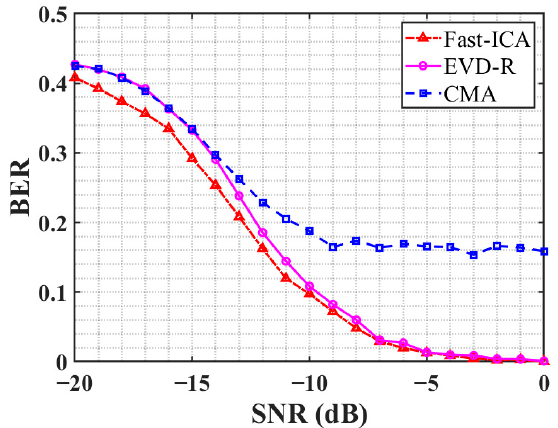
Figure 7. Variation curve of BER with SNR for different methods.